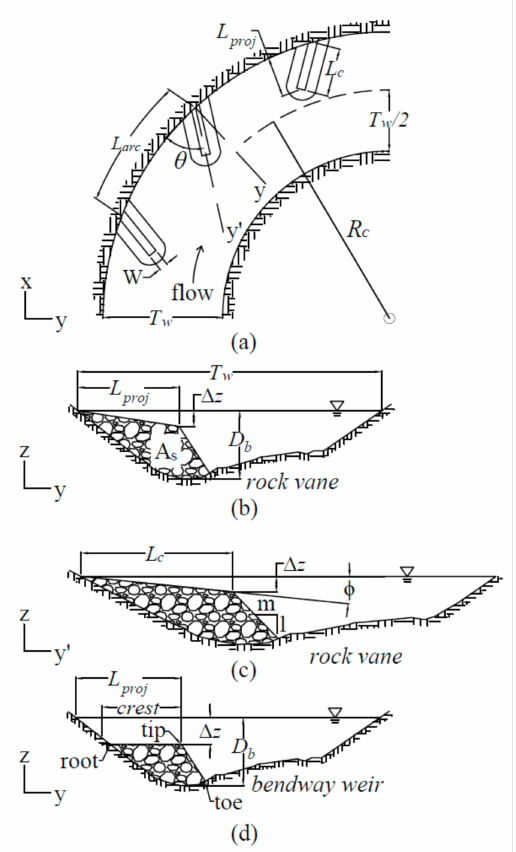
Figure 1. Geometric parameters of bendway weirs and rock vanes: ( a ) illustrates the plan view geometry, ( b ) illustrates a rock vane projected onto a cross-section perpendicular to the flow direction (y-axis), ( c ) illustrates the parameters of a rock vane on a cross-section taken along the crest of the structure ( y ’-axis), and ( d ) illustrates the parameters of a bendway weir on a cross-section perpendicular to the flow direction ( y